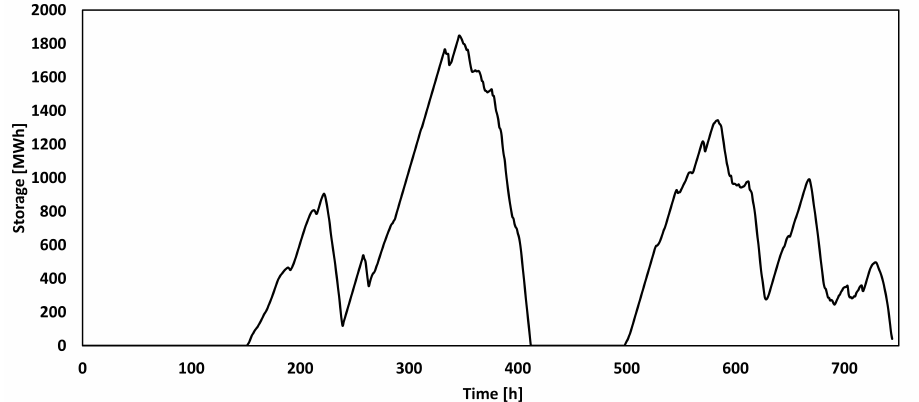
Figure 13. The power storage versus